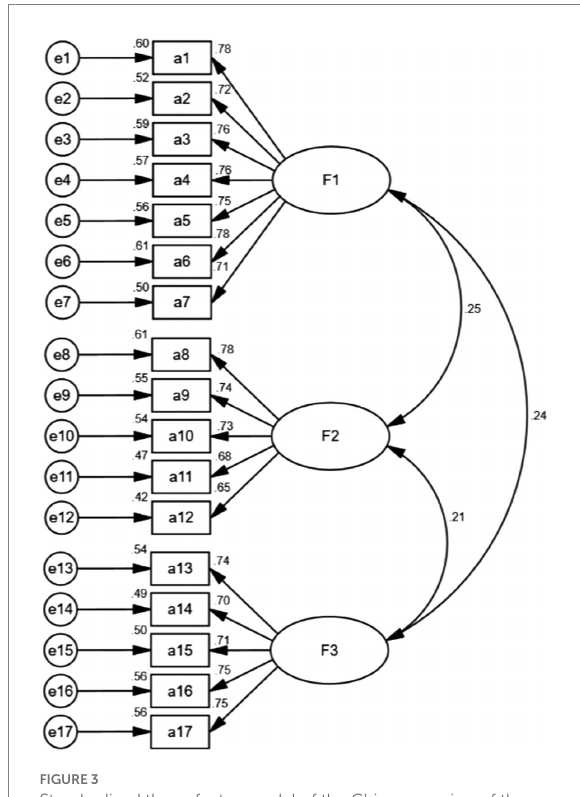
FIGURE 3 Standardized three-factor model of the Chinese version of the FH